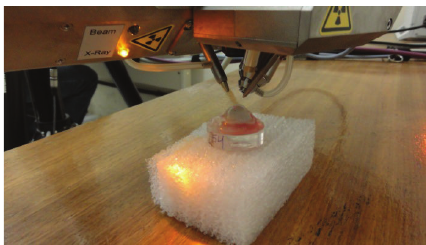
Figure 1: Spectrometric micro X-ray fluorescence ( 𝜇 XRF). Bruker Model Spectra Artax (Berlin, Germany).